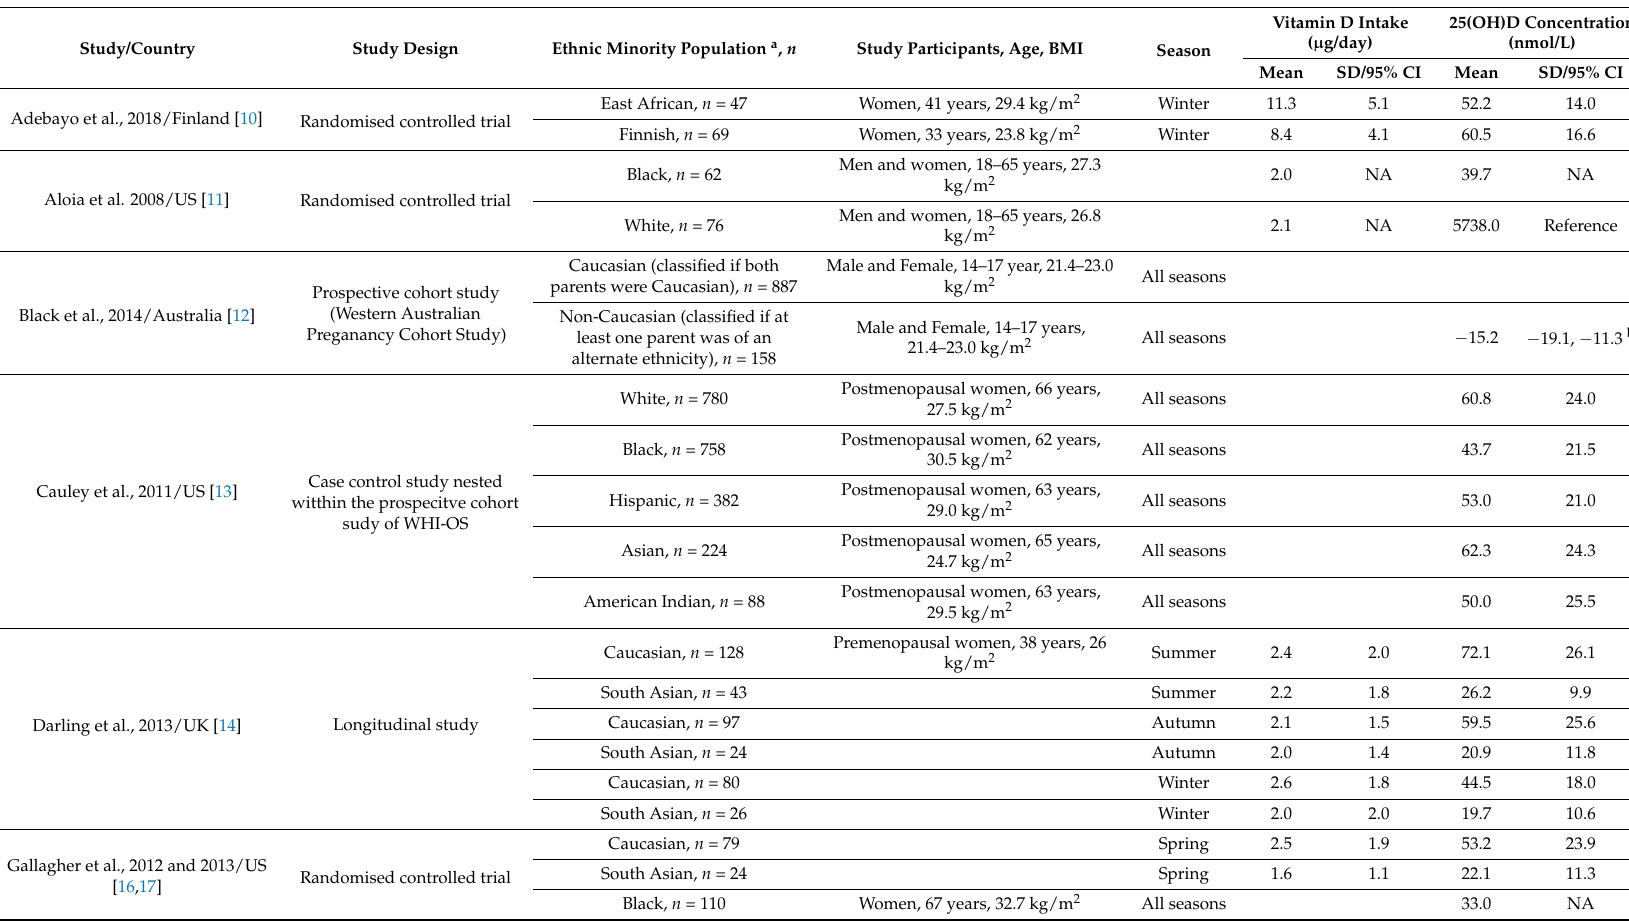
Table 1. Summary of studies investigating the vitamin D status (25(OH)D concentration) in ethnic minority populations (in alphabetic